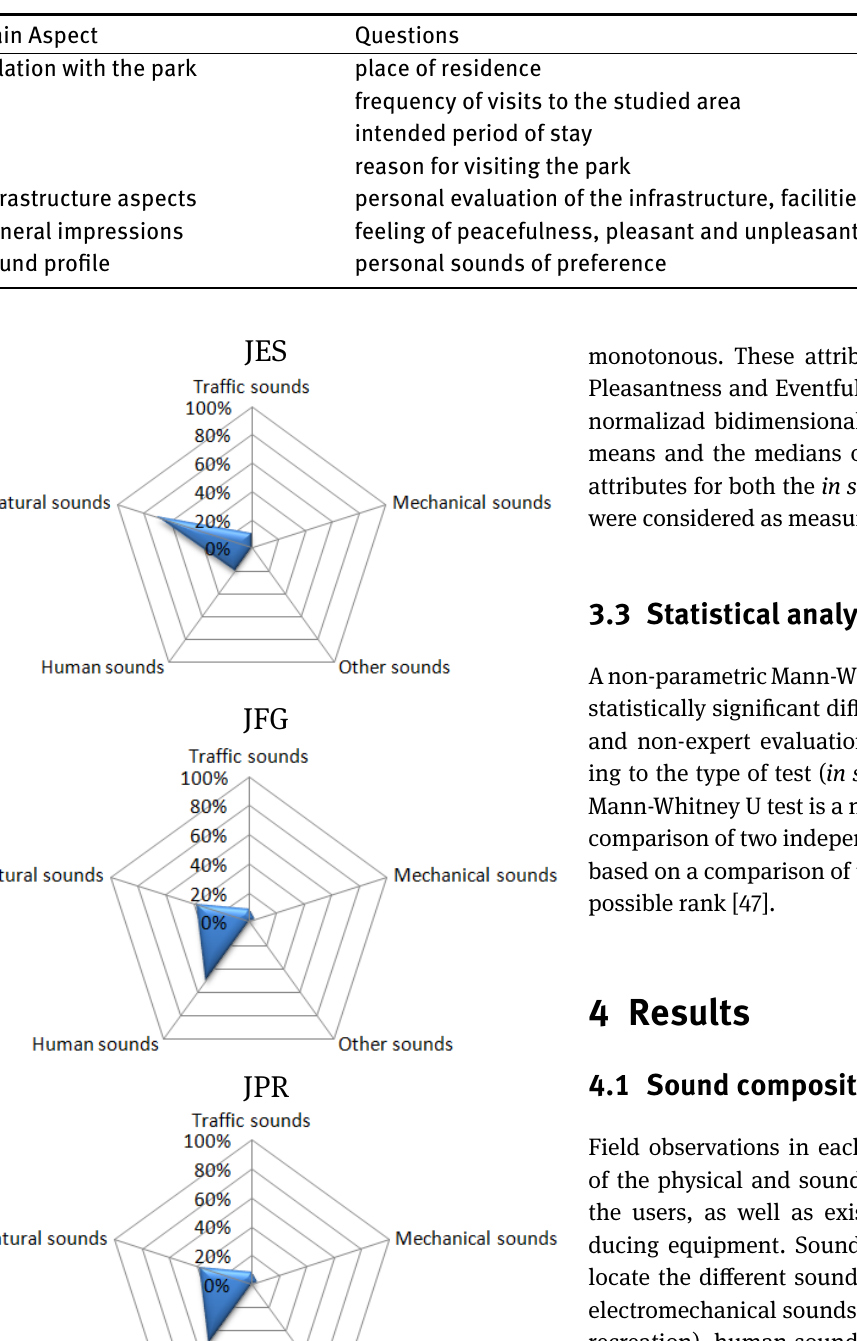
In this process, eight perceptual attributes were con- sidered, as in Axelsson’s model [22]: pleasant, chaotic, exciting, uneventful, calm, annoying, eventful,